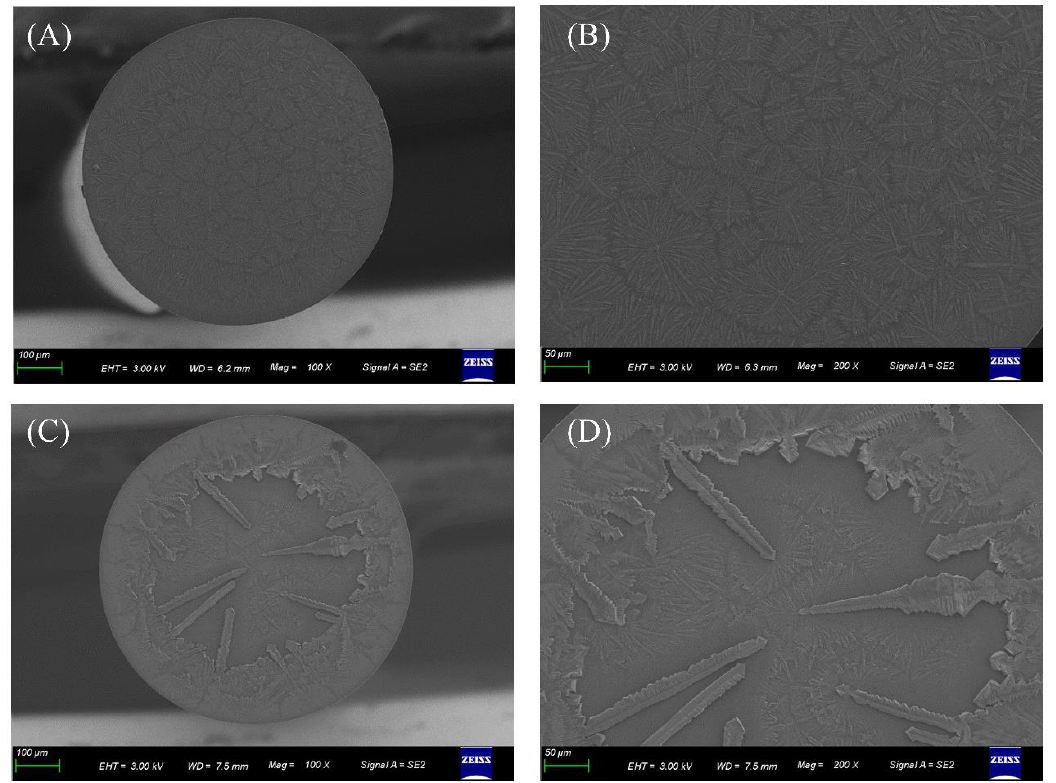
Figure 5. Generation and characterization of the AMEC-induced red precipitates on the optical fiber tips. ( A – D ) SEM images of the optical fiber tips when submerged into AMEC solution to react with HRP bonded on the second antibody to attain signals up to 1.4 nm ( A , B ) and 16 nm ( C , D ).